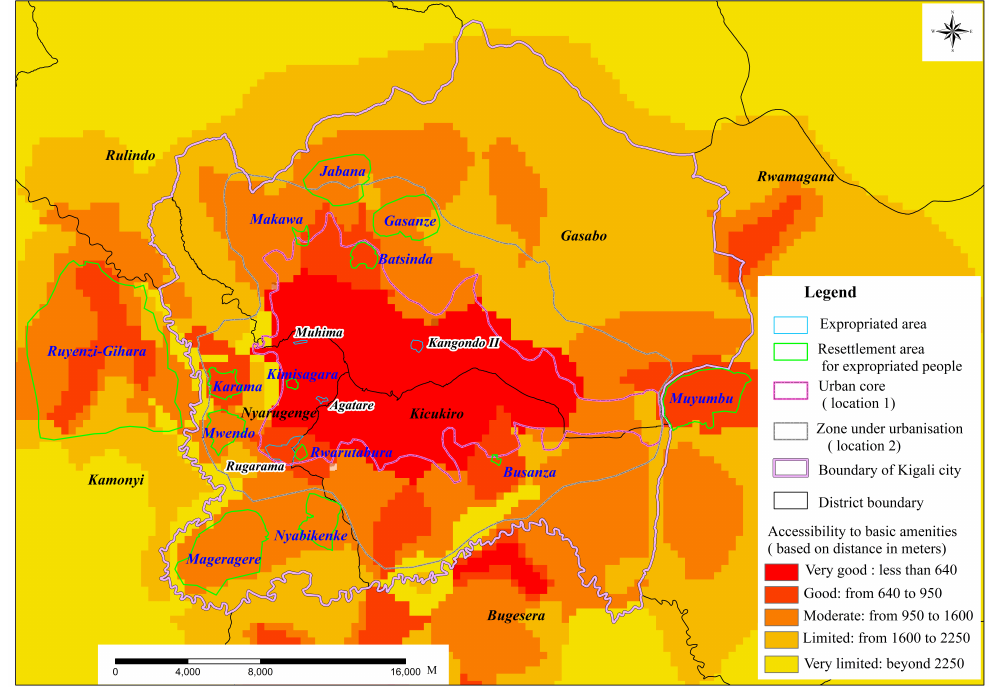
Figure 6. Figure8.This is a figure, Schemes follow the same formatting. If there are multiple panels, Figure 8. Distance to basic amenities in the origin and destination areas for the expropriated people. they should be listed as: ( a ) Description of what is contained in the first panel. ( b ) Description of what Data source: Kigali city, Geo-datasets on socio-economic facilities in Kigali city and neighbouring is contained in the second panel. Figures should be placed in the main text near to the first time they districts; NSIR and CGIS-UR are cited. A caption on a single line should be centered.